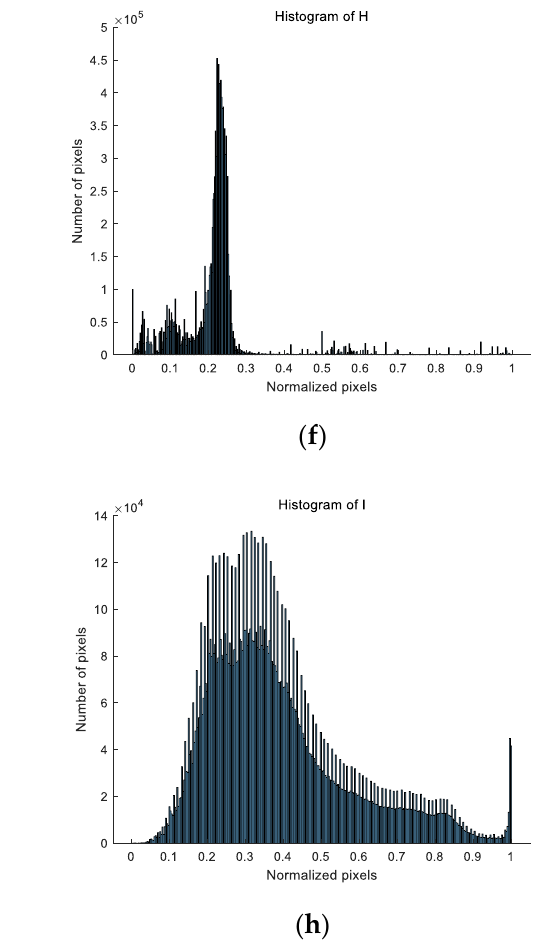
Figure 3. Original image and HSI space component. ( a ) Grayscale image. ( b ) Hue H. ( c ). Saturation S. ( d ) Intensity I. ( e ) Histogram of gray image. ( f ) Histogram of hue. ( g ) Histogram of saturation. ( h ) Histogram of intensity.